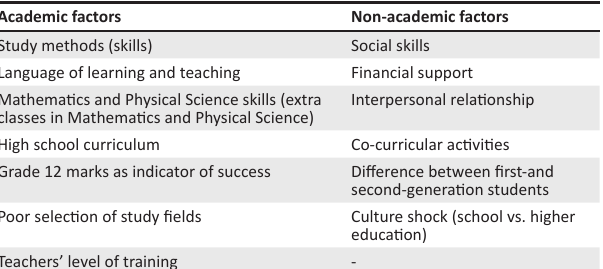
TABLE 3: Overview of the academic and non-academic factors that influence student success or